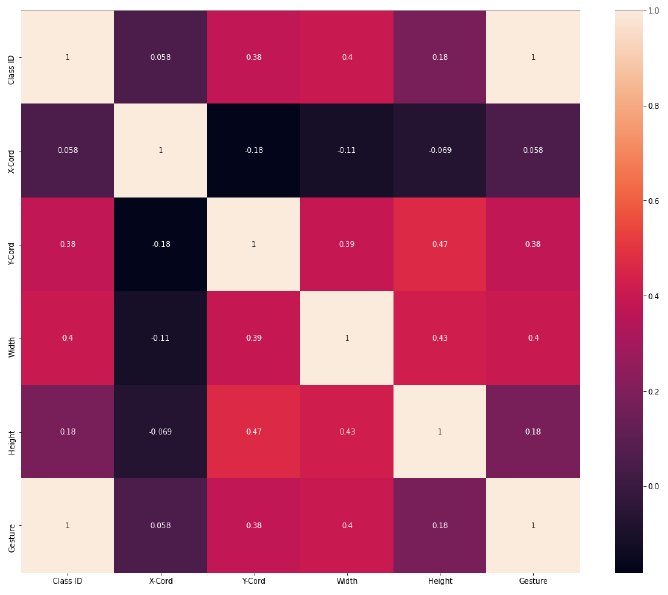
Figure 2. Heat map of the YOLO-labeled dataset.